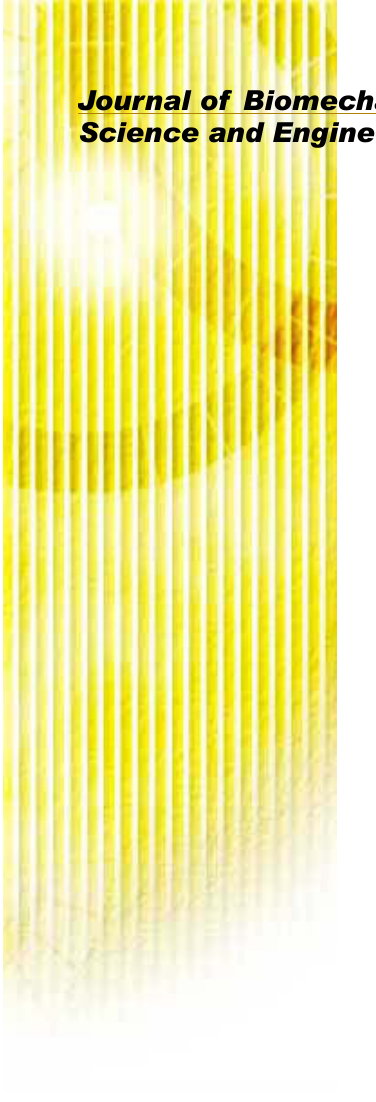
Fig. 8 Disturbance δ u + , δ q + , and δθ + in the stable oscillatory mode